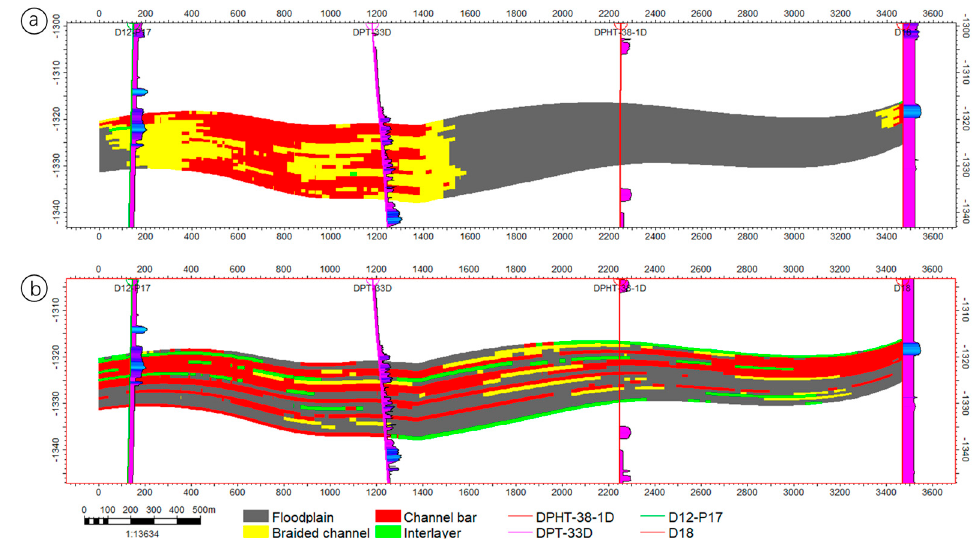
Figure 13. Cross-sectional view of simulation results of different methods (see Figure 11a for cross- sectional), ( a ) result of multiple point geostatistical simulation profile, ( b ) result of sequential indi- cation simulation profile.